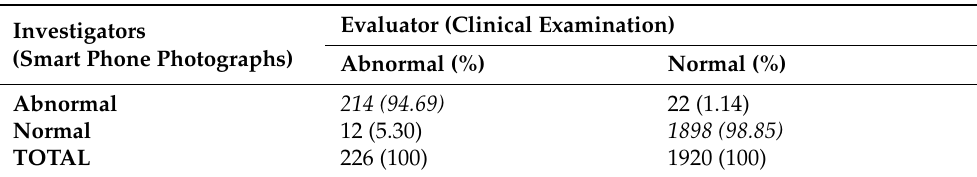
Table 2. Sensitivity and specificity of detecting ocular morbidities using unanimously graded smart- phone photographs. Figures in italics represent the sensitivity and specificity.